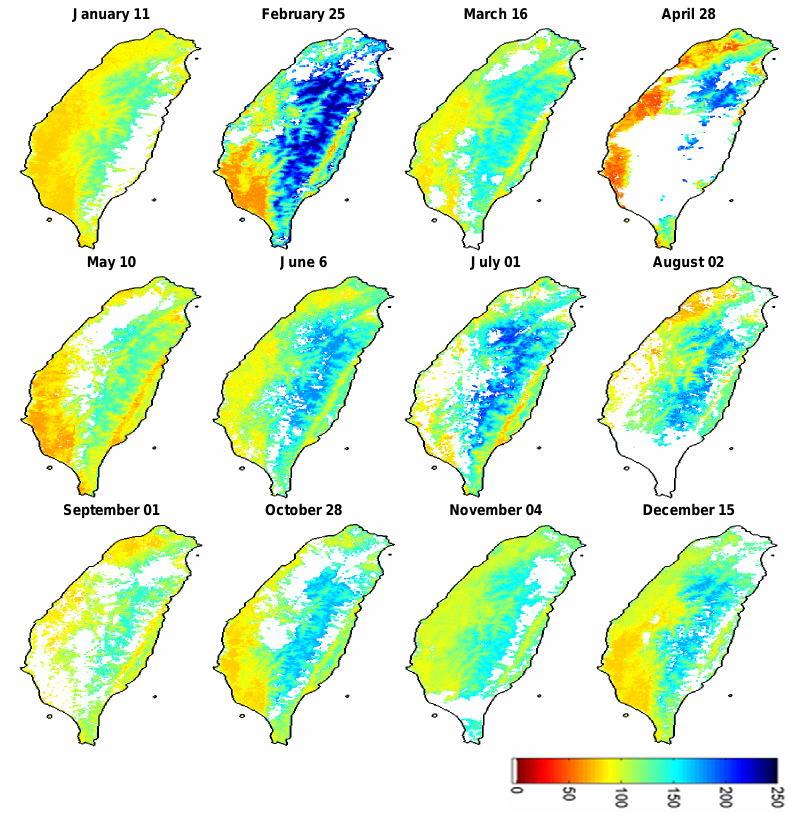
Figure 6. Evolution of 1-km resolution surface soil moisture (g cm -3 ) retrieved from TVDI and AMSR-E data for